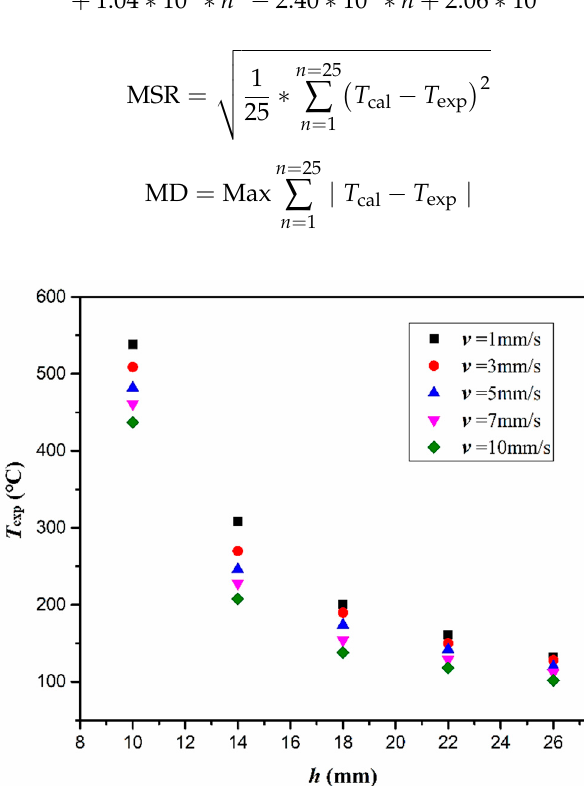
Figure 6. The measured temperature of CFRP substrate surface ( T exp ) as a function of nozzle speed ( v ) and nozzle distance ( h ).